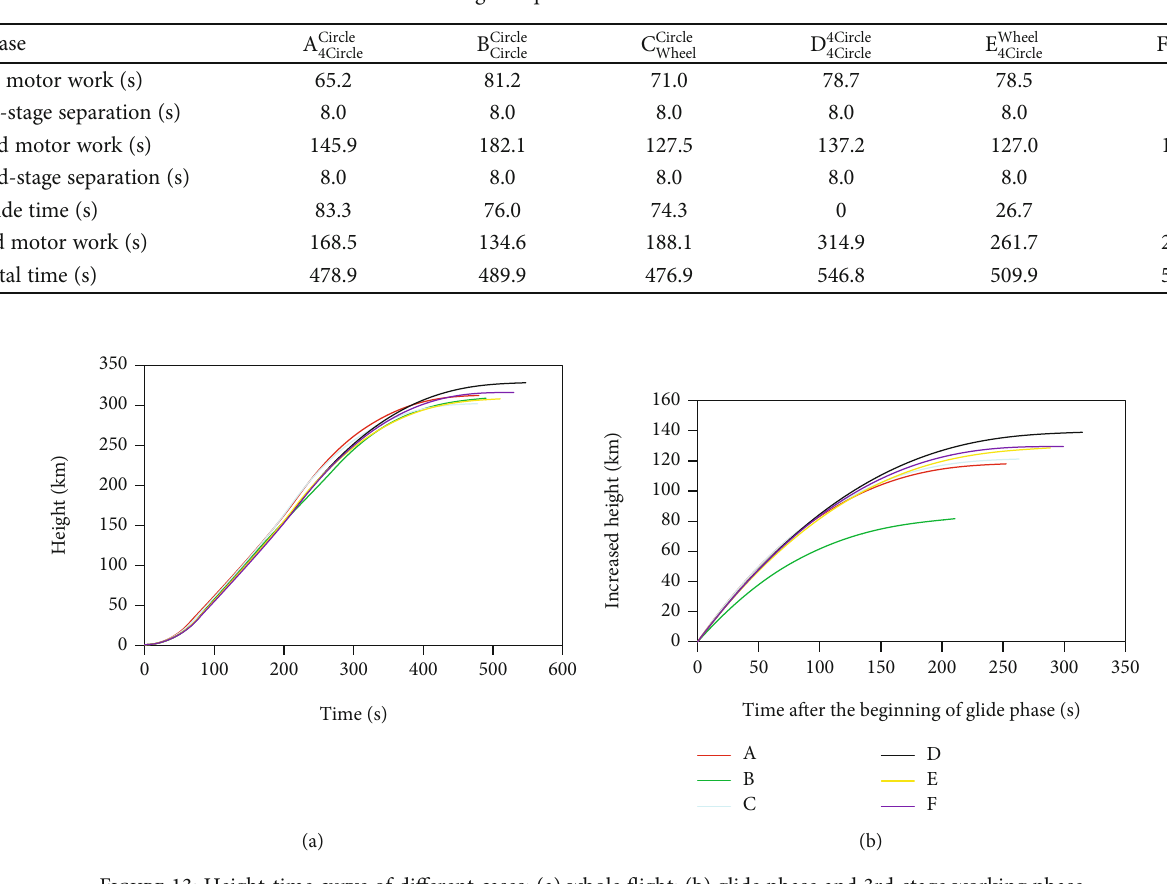
Figure 12: Thrust and oxidizer-fuel ratio with time of the 1st stage in cases A, E, and F: (a) thrust; (b) oxidizer-fuel ratio. Table 8: Flight sequence of di ff erent cases of SLV.